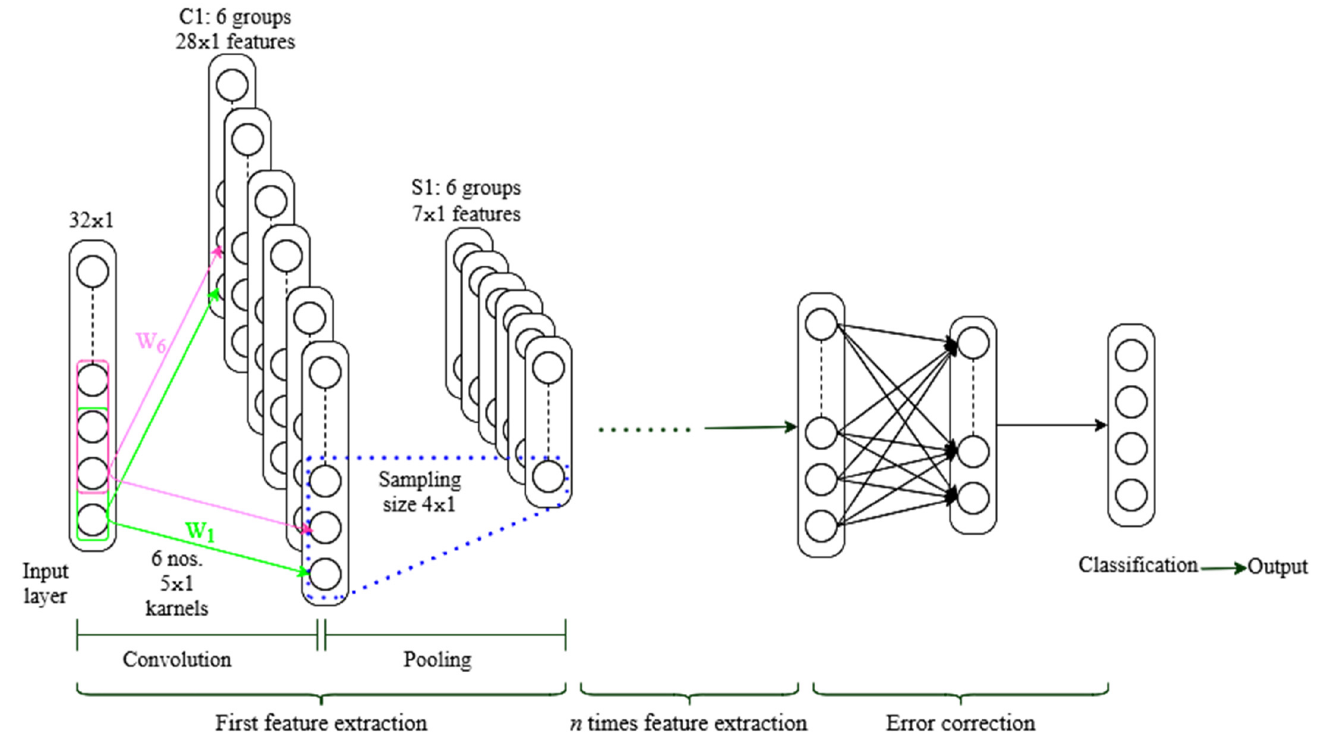
Figure 8. Working procedure of convolution neural network (CNN).